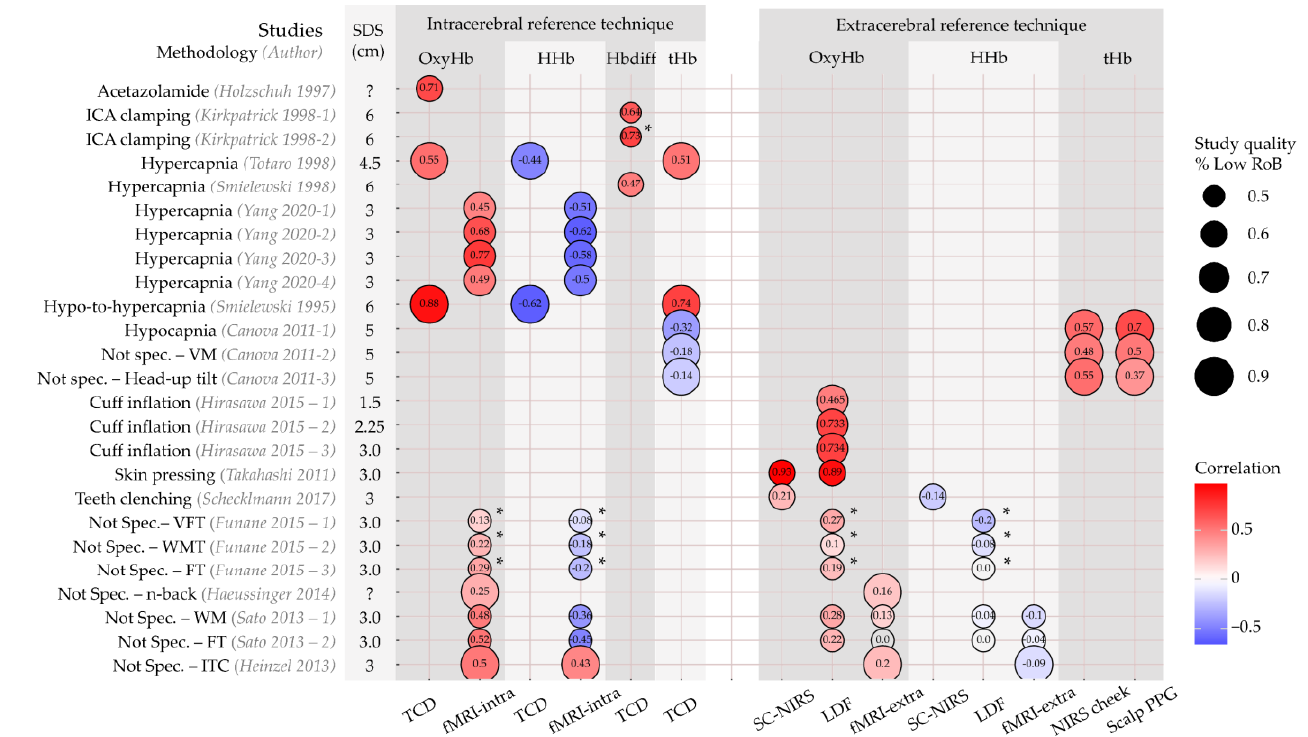
Figure 3. Haemoglobin concentrations; correlation between reference techniques and NIRS indices per study. Rows represent individual sub-studies. Columns have been grouped into intracerebral and extracerebral reference techniques and per NIRS index (OxyHb, HHb, Hbdiff, tHb). Circle size represents the percentage of CA domains categorized as ‘Low’ risk of bias or applicability concerns. Colour represents the correlation, with hot colours expressing positive correlation and cold colours negative correlation. Correlation is also expressed numerically in the circle. Source–detector separation (SDS) is shown in the second column. *: NIRS-index was corrected for extracerebral contamination. Extra, extracerebral; fMRI, functional magnetic resonance imaging; FT, finger tapping task, Hb, haemoglobin; Hbdiff, difference between OxyHb and HHb; HHb, deoxygenated Hb; intra, intracerebral; ITC, intertemporal choice task; LDF, laser doppler flowmetry; NIRS, near-infrared spectroscopy; Not spec., no specifically intra-or extracerebral perfusion modification; OxyHb, oxy- genated Hb; PPG, photoplethysmography; RoB, risk of bias; SC, short-channel; SDS, source–detector separation; TCD, transcranial doppler; tHb, total Hb; VFT, verbal fluency task; VM, Valsalva manoeu- vre; WMT, working memory task. Studies are [27–40]. Figure inspired by Bernaldo-de-Quiros and co-workers